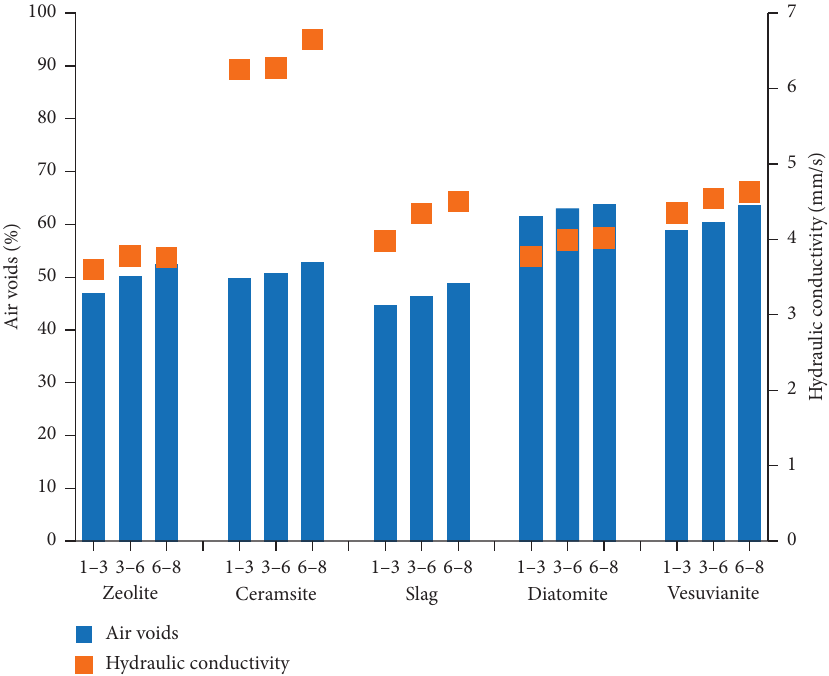
Figure 7: Air-void fractions and initial hydraulic conductivity of different filter media.